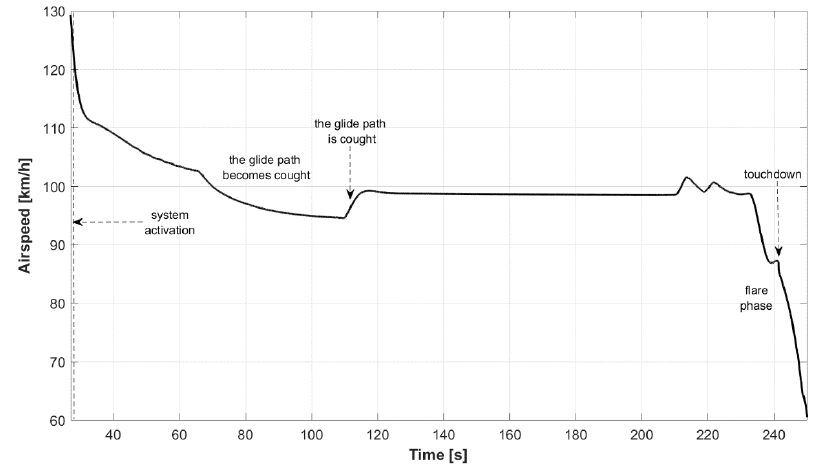
Figure 23. The airspeed variations during landing.